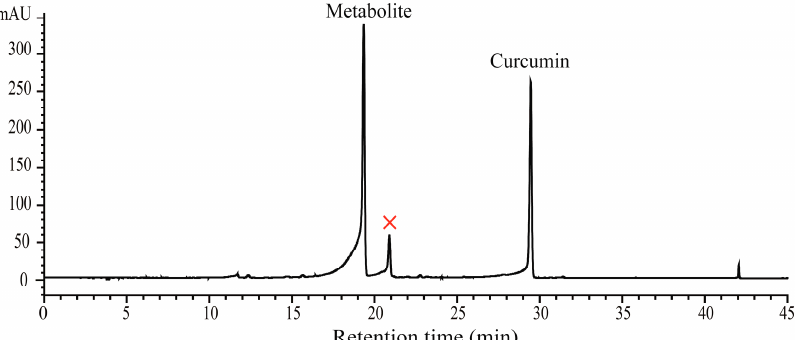
Figure 1. Biotransformation of curcumin by B. subtilis ATCC 6633. The strain was cultivated in potato dextrose culture medium containing curcumin 1.0 mg/50 mL. The 16-h cultivations of the fermentation broth were extracted with 50 mL of ethyl acetate three times, and the organic phase was concentrated and dissolved in methanol for HPLC analysis.